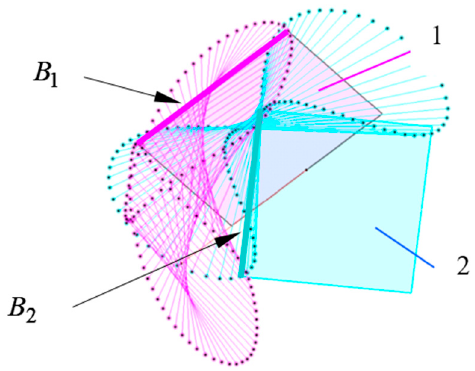
Figure 7. The positions of a line segment a tt ached to a plate with respect to the other one.